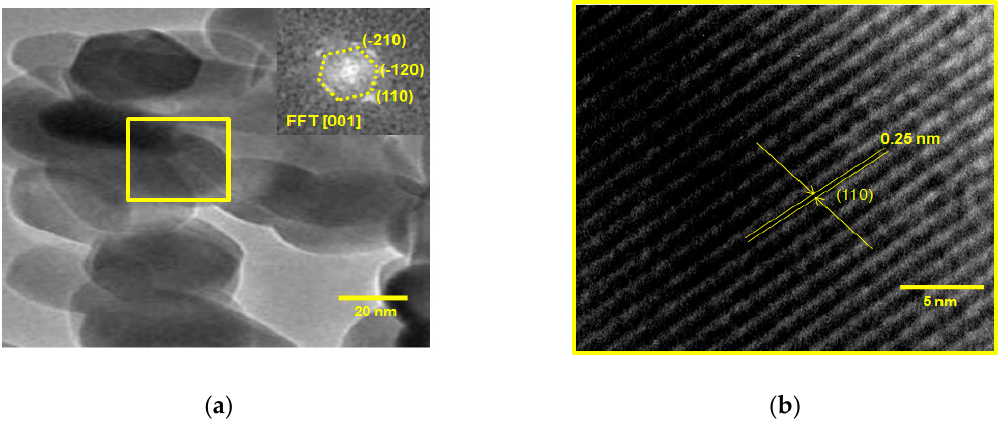
Figure 5. TEM micrograph of ( a ) hematite nanoparticles (HNPs), inset: corresponding fast Fourier-transform (FFT) pattern from the SAED and ( b ) lattice fringes at the (1 1 0) plane.